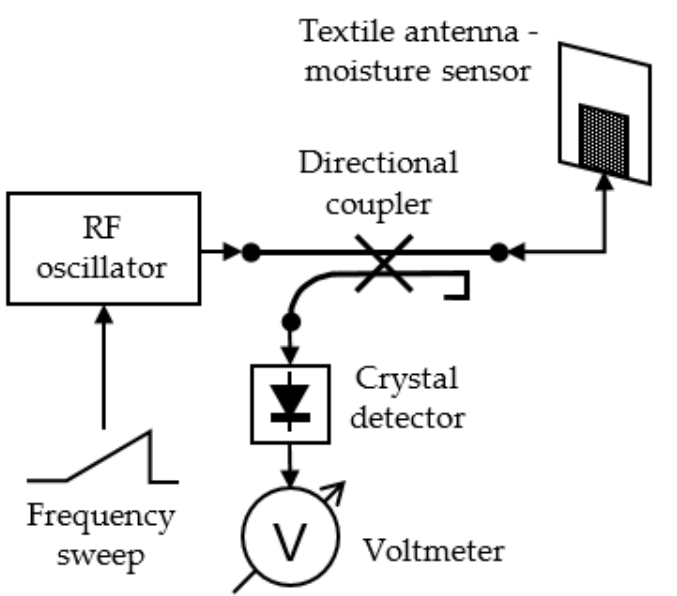
Figure 18. Textile antenna as moisture sensor, reflection mode setup [16].